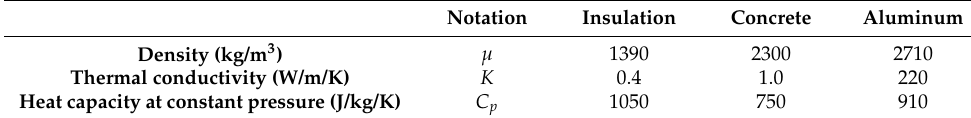
Table 3. Material properties used in the COMSOL model.